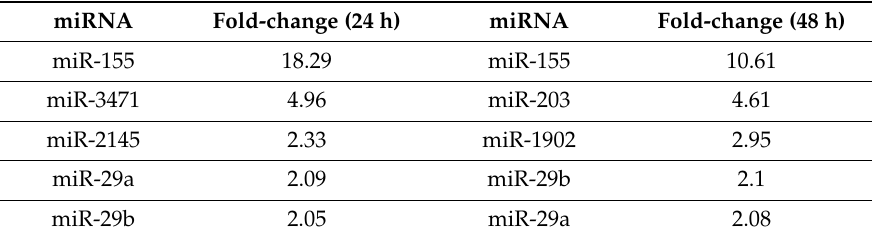
Table 2. Upregulated miRNAs in Zika virus (ZIKV)-infected neurons at 24 h and 48 h.